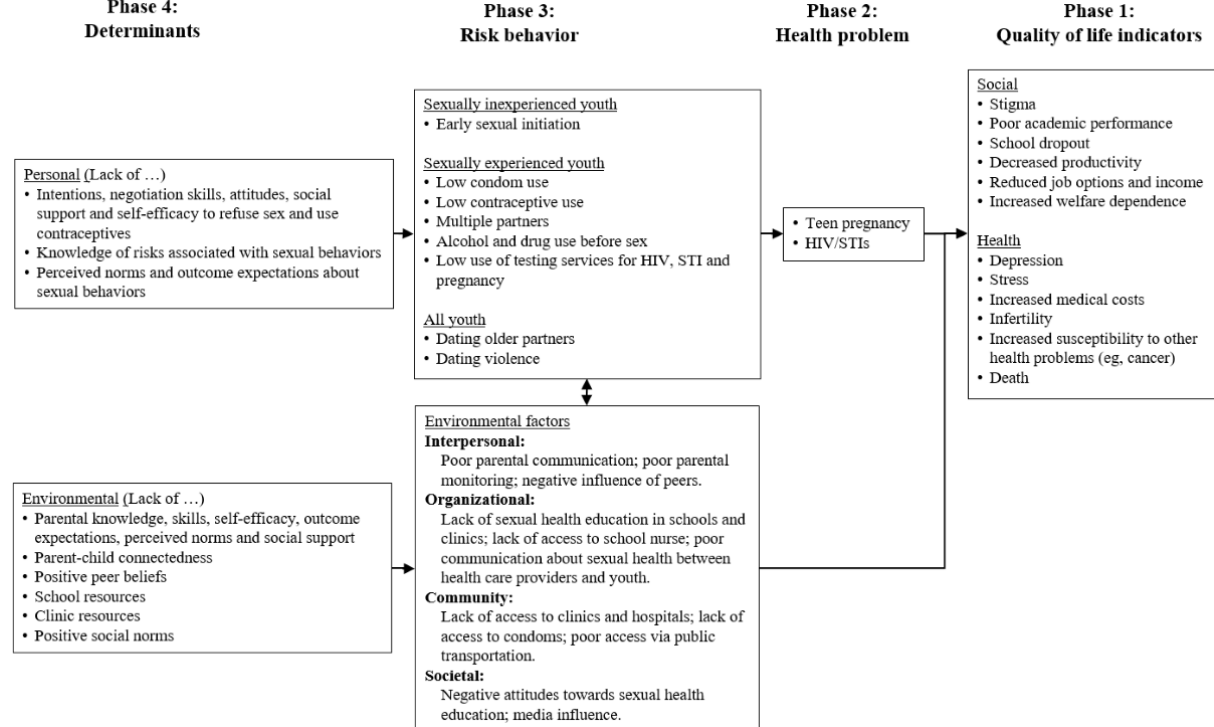
Figure 1. Predisposing, reinforcing, and enabling constructs in educational diagnosis and evaluation “logic model of the problem” of young adolescent sexual behavior for the Secret of Seven Stones. STI: sexually transmitted